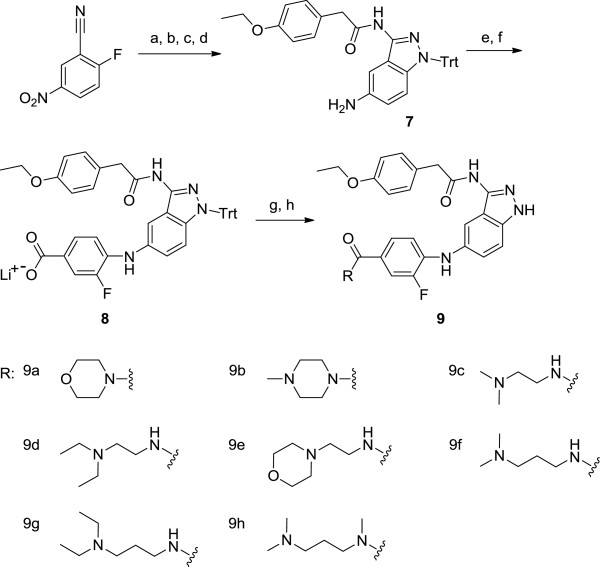
Synthetic scheme for compound 9a to 9h. Reagents and experimental conditions: a) H2NNH2, n-BuOH, reflux, b) i) p-C2H5OC6H4CH2COCl, THF, reflux, ii) 2N NaOH c) TrtCl, Et3N, CH3CN, reflux, d) Pd/C, H2, MeOH/DCM, e) 2-F-4-EtO2CC6H3Br, Pd2(dba)3, (R)-BINAP, NaOBu-t, toluene, reflux, f) LiOH, THF:H2O:MeOH (3:1:1), reflux, g) RH, EDC, HOBT, DMF, h) TFA, DCM.